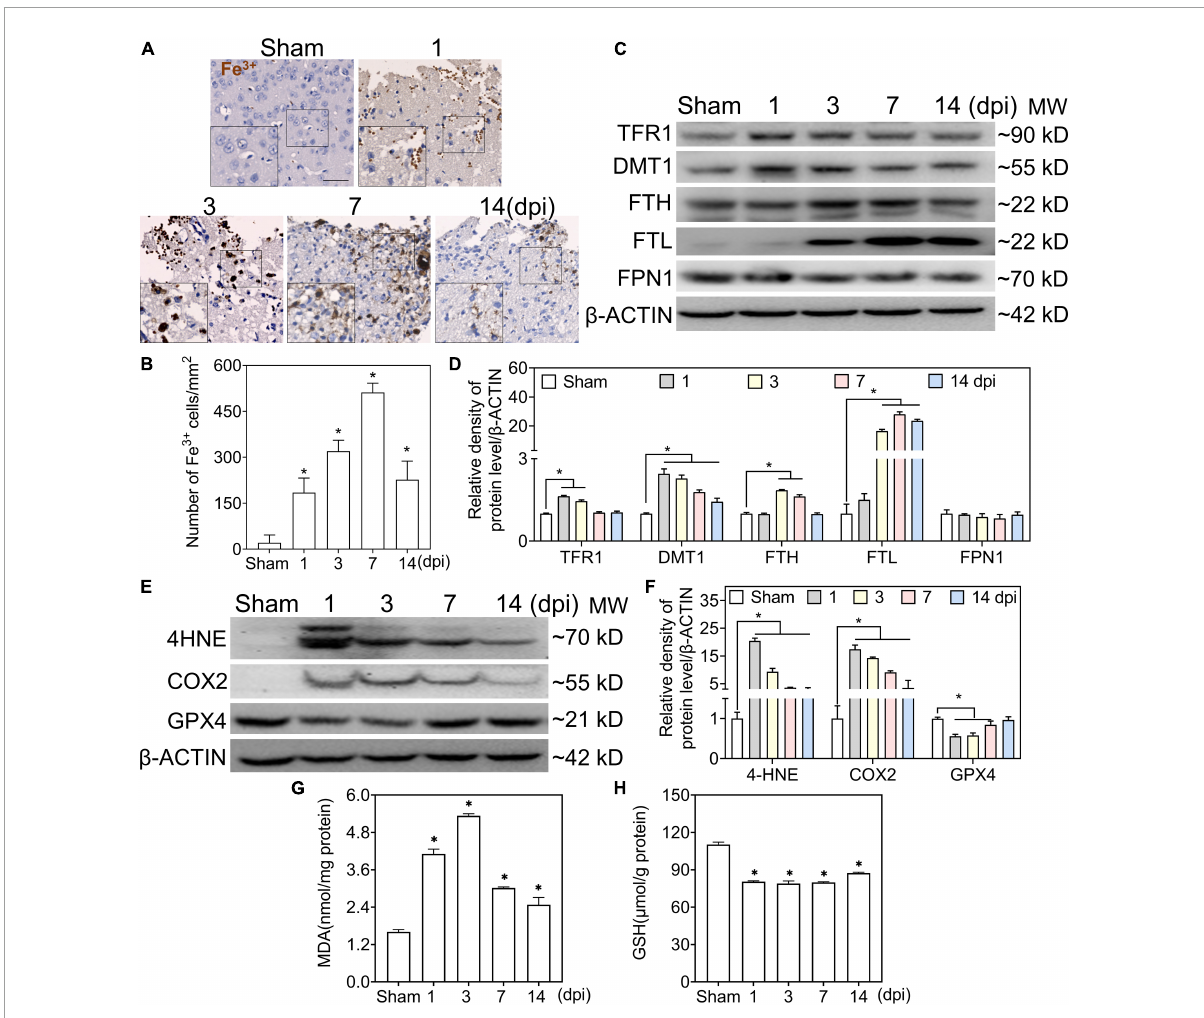
FIGURE1 Traumatic brain injury (TBI) accounts for iron accumulation, abnormal iron metabolism, and ferroptosis. (A) Representative image of DAB-enhanced Perl’s (Fe 3 + ) staining of ipsilateral-injured cortices at the indicated time (scale bar = 50 µ m). (B) Quantitative analysis of Fe 3 + -positive cells at different intervals after TBI. Data are presented as mean ± SD, and n = 6. (C) Representative image of Western blotting of TFR1, DMT, FTH, FTL, and FPN1 in injured cortices at the indicated time. (D) Relative intensity of proteins in panel (C) . Data are presented as mean ± SD, and n = 6. (E,F) Representative bands and corresponding quantitative analyses of 4-HNE, COX2, and GPX4 in ipsilateral cortices at different time points. Data are presented as mean ± SD, and n = 6. (G,H) The levels of MDA and GSH in injured cortices at the indicated time. Data are presented as mean ± SD, and n = 3. * p < 0.05 versus the sham group. DAB, 3,3-diaminobenzidine; SD, standard deviation; TFR1, transferrin R1; DMT1, divalent metal transporter 1; FTH, ferritin heavy chain; FTL, ferritin light chain; FPN1, ferroportin1; 4-HNE, 4-hydroxynonenal; COX2, cyclooxygenase-2; GPX4, glutathione peroxidase 4; MDA, malondialdehyde; GSH,